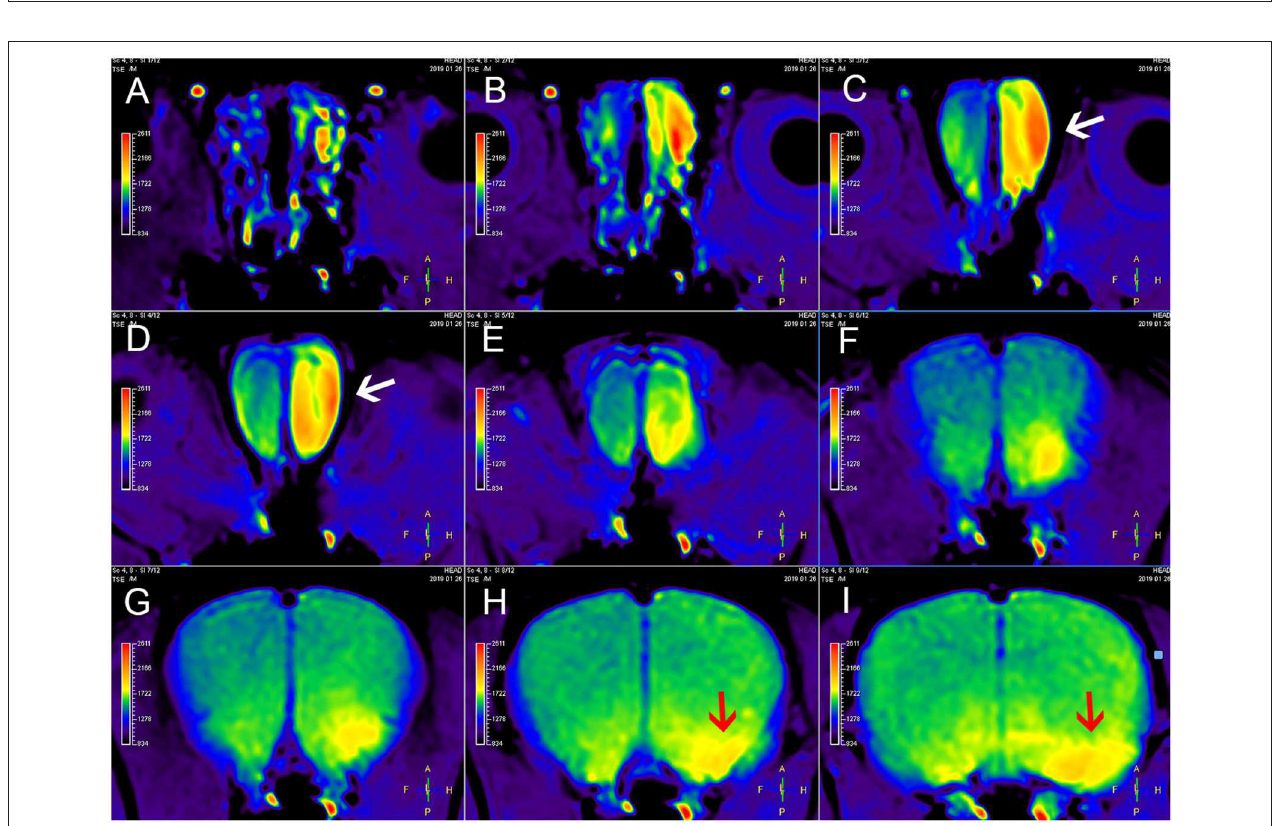
FIGURE 2 | MEMRI of a rat using left nasal administration of MnCl 2 . Mn 2 + uptake into the olfactory bulb (white arrows) and transport to olfactory cortex along the olfactory pathway. The red arrows indicate the lateral olfactory tract with unilateral enhancement. From (A–I) are axial continuous images of rat brain MRI.